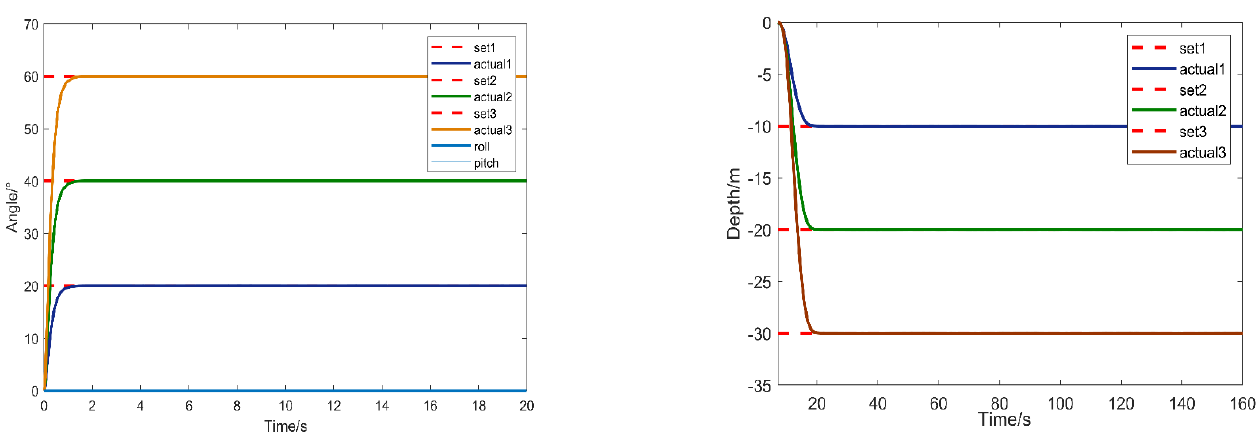
Figure 12. The depth and attitude control simulation.